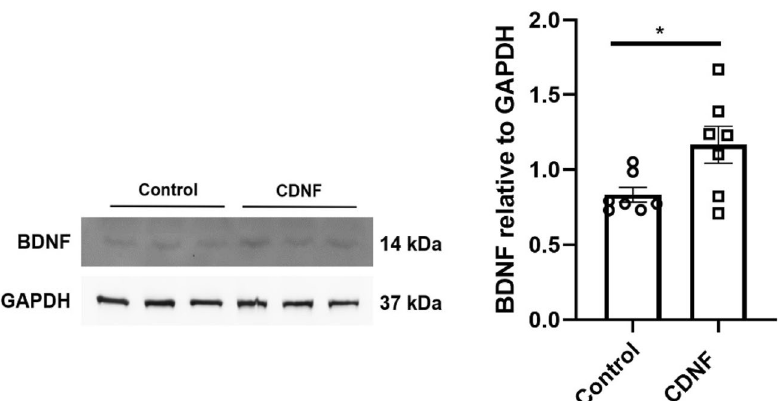
Figure 10. CDNF increases the levels of mature BDNF in striatal neurons expressing mutant huntingtin protein. Striatal neurons expressing mutant huntingtin were treated for 24 h with 100 ng/ml CDNF or vehicle. Cell lysates were subjected to immunoblotting for BDNF, using GAPDH as loading control. Left, immunoblot. Right, histogram with quantification of the relative ratio of BDNF compared with GAPDH. Values represent mean ± SEM, * p < 0.05, unpaired t-test, n =